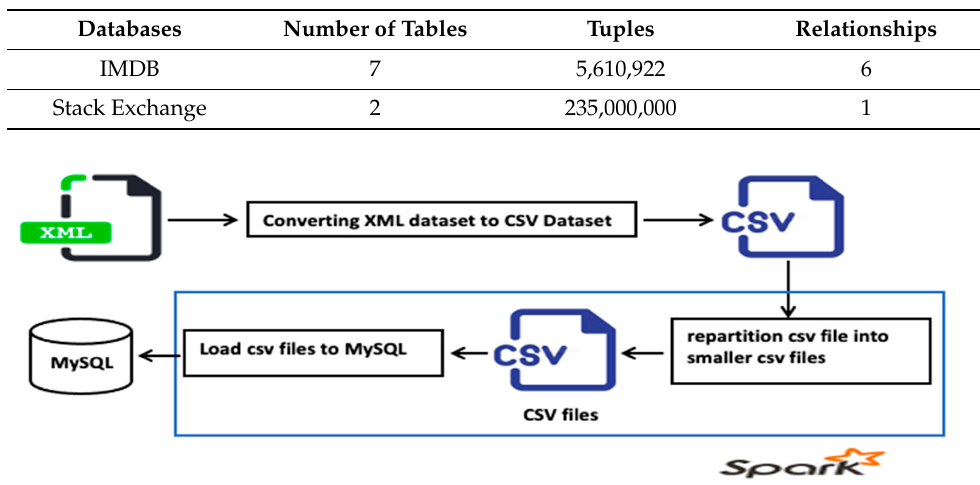
Table 5. Characteristics of the databases.